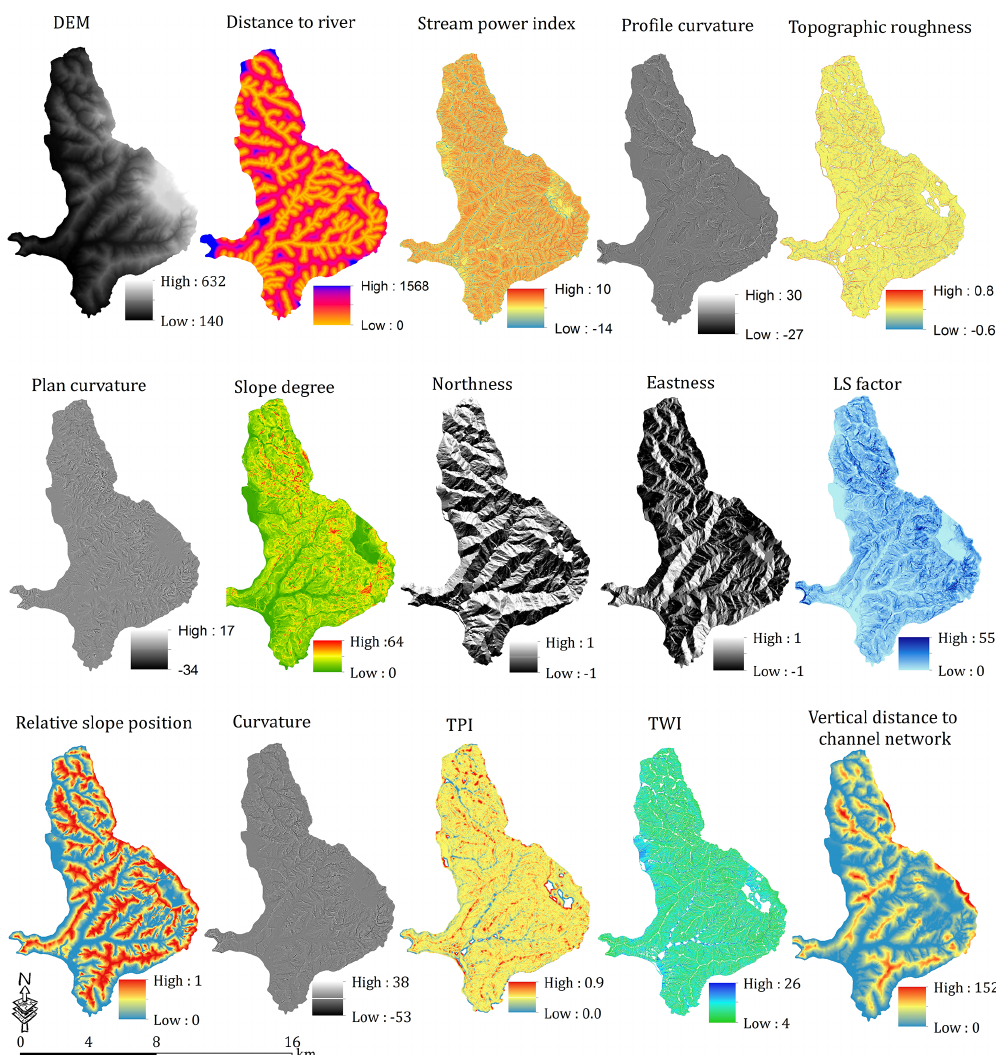
Figure 2. DEM (digital elevation model) and its derivatives used in conventional and conventional plus path-dependent landslide suscep- tibility models. TPI means topographic position index, TWI means topographic wetness index, and LS factor stands for slope length and steepness